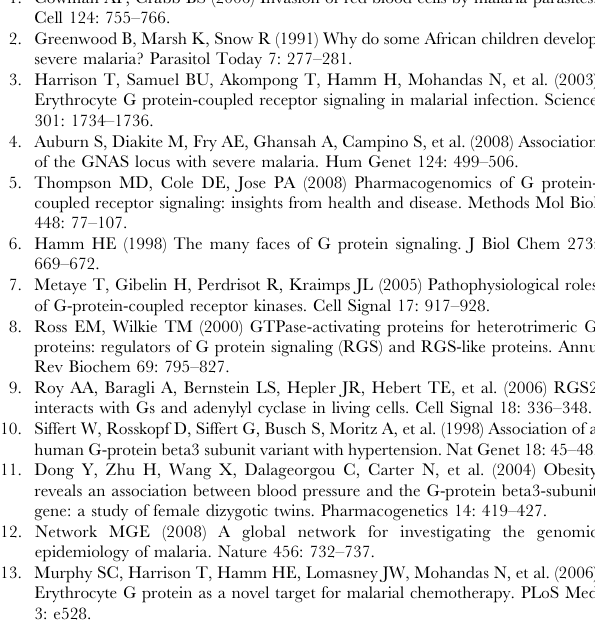
Table S1 Individual study and pooled odds ratios of allelic associations in all genes investigated. Odds ratios corresponding to severe malaria associations with the minor allele of the given locus are presented for individual studies and pooled studies (meta- analysis). Z scores and corresponding P-values are presented for the pooled associations. Q scores and corresponding P-values are presented for Cochran’s test of heterogeneity between the studies. Odds ratios refer to the minor allele at each locus. Cochran’s Q- test for heterogeneity on 4 degrees of freedom. CC: Case-control.